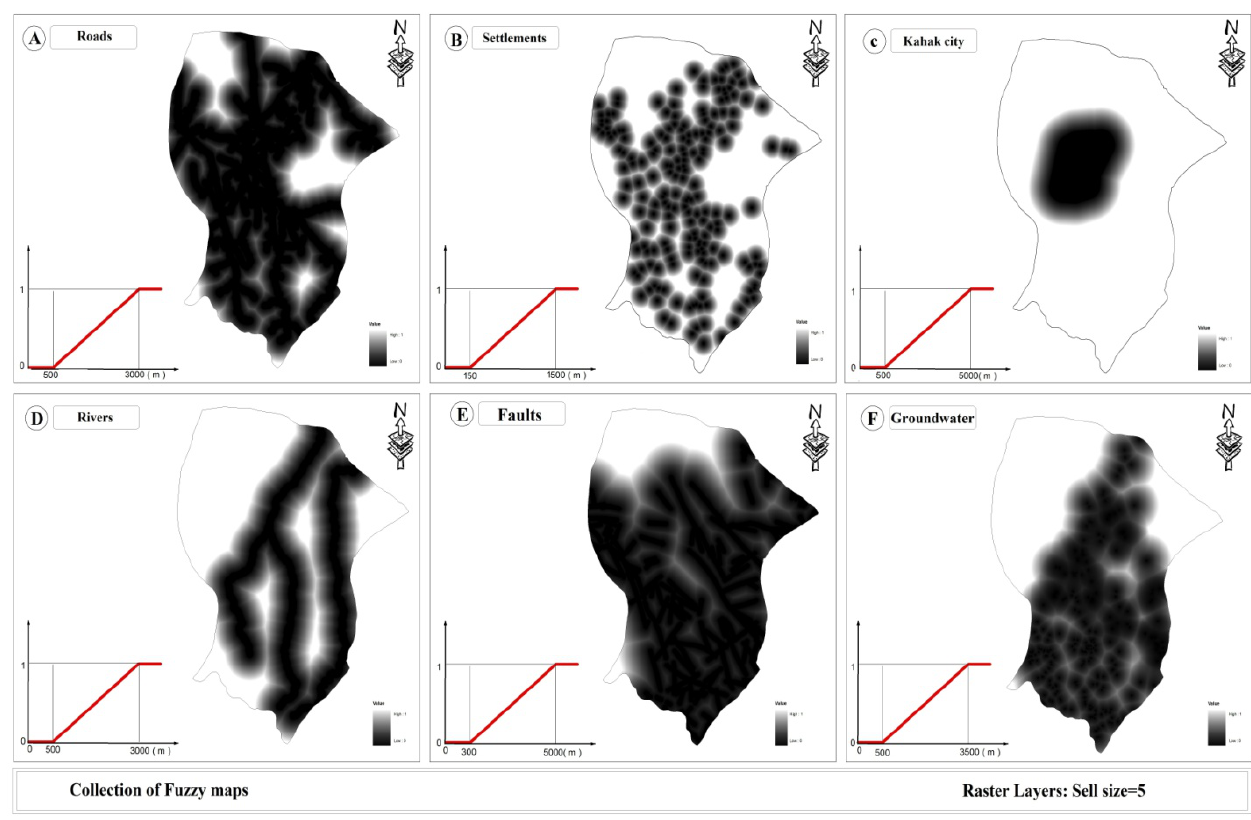
Figure 4. Collection of fuzzy maps